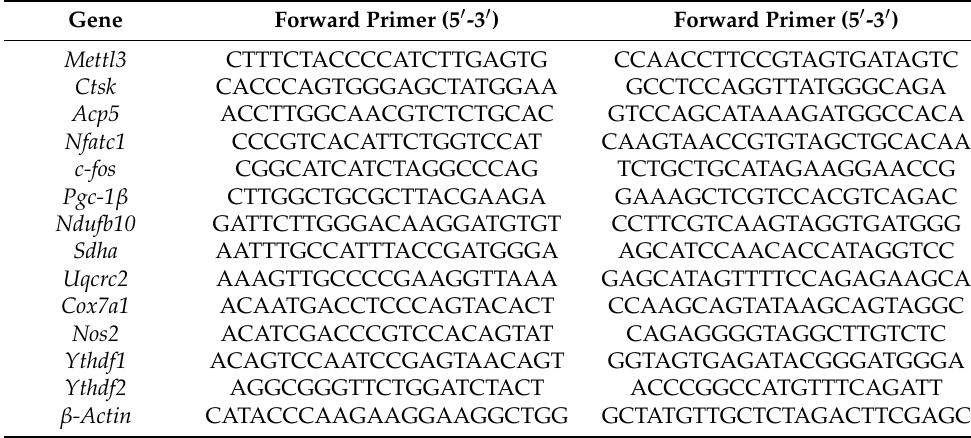
Table 3. Primer sequences for